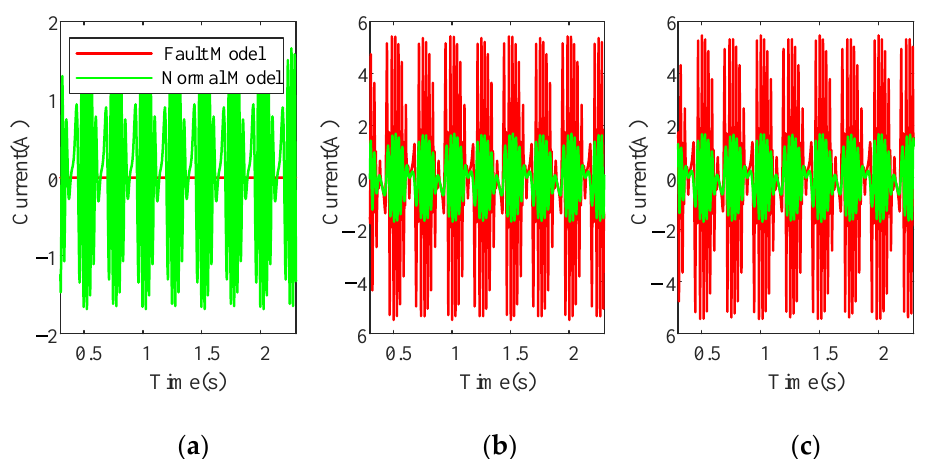
Figure 8. Fault data of A-phase open circuit. ( a ) A-phase current; ( b ) B-phase current. ( c ) C-phase current.